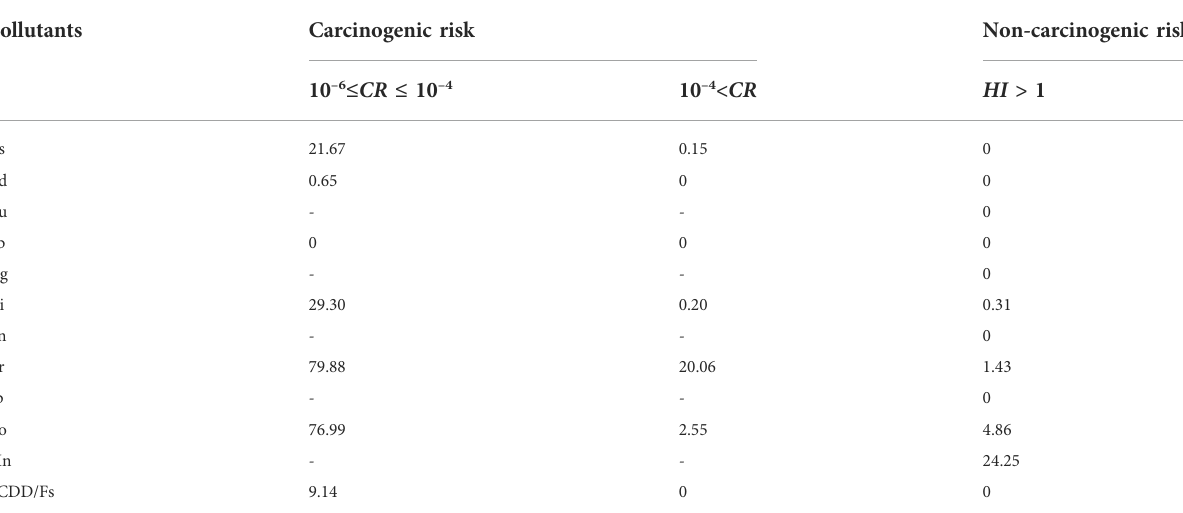
TABLE 3 The probabilities of exceeding risks for pollutants